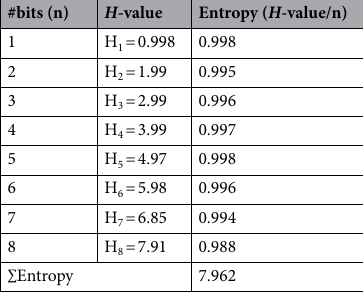
mentary Table S3. The optimal evolutionary parameters obtained were as follows: {population size: 2, generations: 5, crossover: